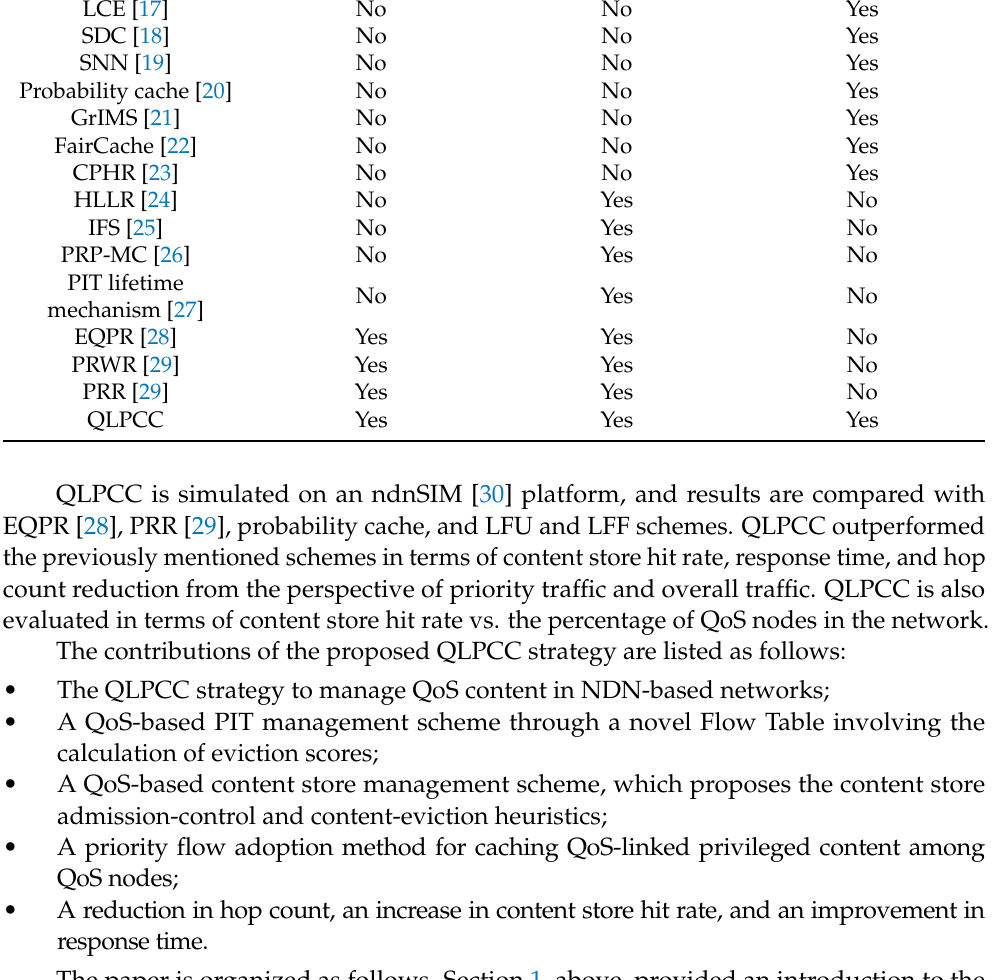
Table 1. Uniqueness of QLPCC when compared with existing schemes. Schemes QoS Support PIT